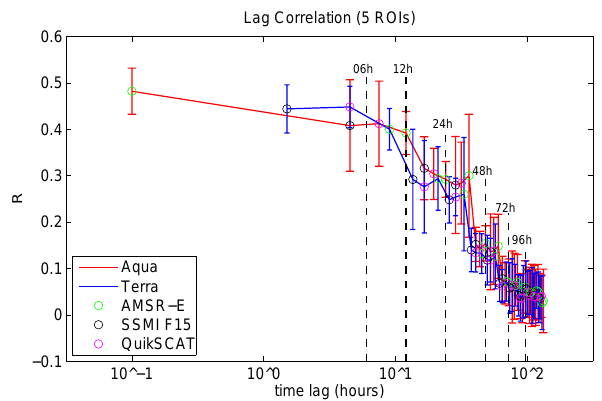
Fig. 6. Correlation coefficients, R , between τ c and W as a function of the time difference between measurements, at the 5 regions of in- terest (regions a–e in Fig. 1). 12 combinations of aerosol (MODIS- Aqua and MODIS-Terra) and wind speed (ascending and descend- ing passes of AMSR-E, QuikSCAT and SSMI) were used. Time difference between the measurements range from 0 to 156h, with intervals of between 1.5 and 4.5h. Points and error bars represent respectively the mean and standard deviation of R for a given time interval at the 5 ROIs. Only data associated with wind speeds higher than 4m/s was used. 12h is identified is the decorrelation time scale for linking surface wind speed marine aerosol optical